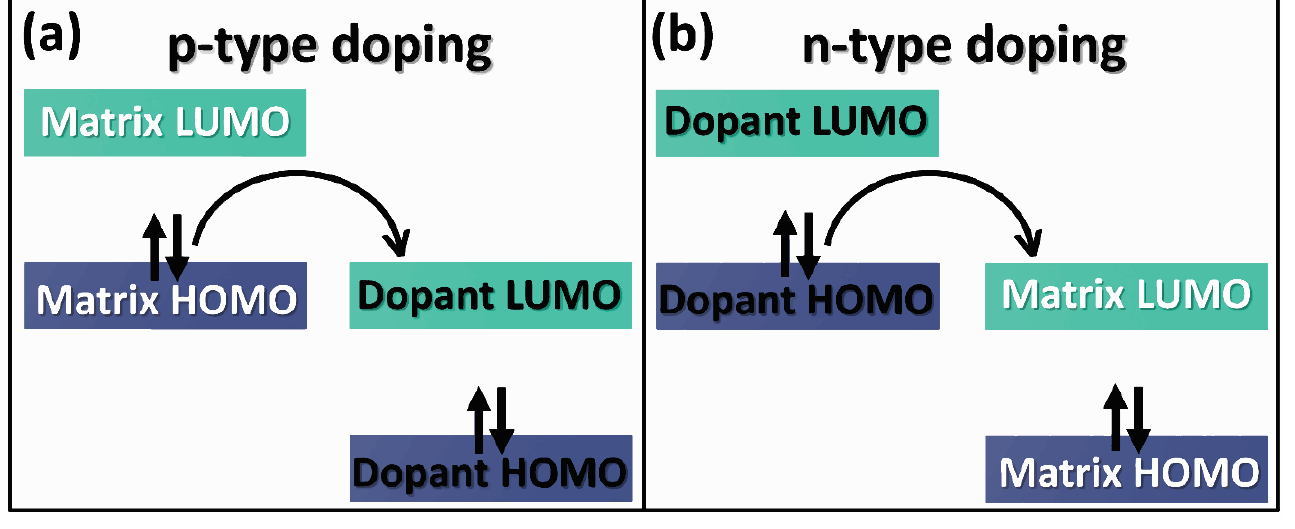
Figure 4. Behavior of ( a ) p-type doping and ( b ) n-type doping in conjugated polymers [1]. In p-type doping, the dopant plays a role as the electron acceptor, while in n-type doping the molecular dopant plays a role as the electron donor. ( a , b ) Reproduced with permission [1]. Copyright 2020, Elsevier.